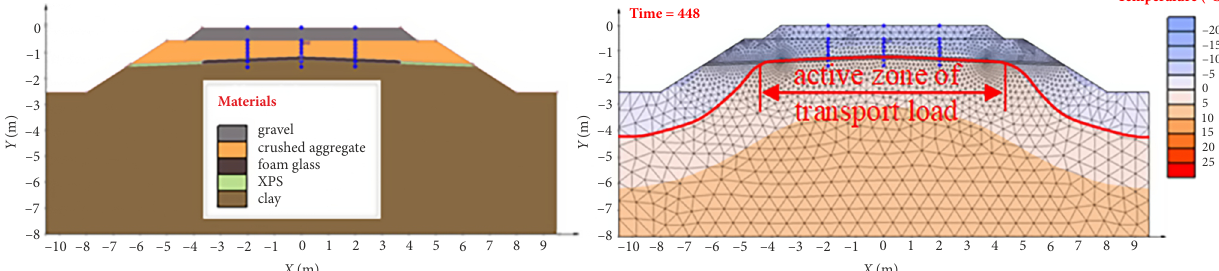
Figure 10. Numerical model 3: design of the combination of two thermal insulation materials (foam glass and extruded polystyrene) in the sub-ballast layers with respect to the applied climatic load I F = 1400 °C, day and θ m = 2 °C (left); day of achieving the maximum freezing depth of the structural layers of the numerical model